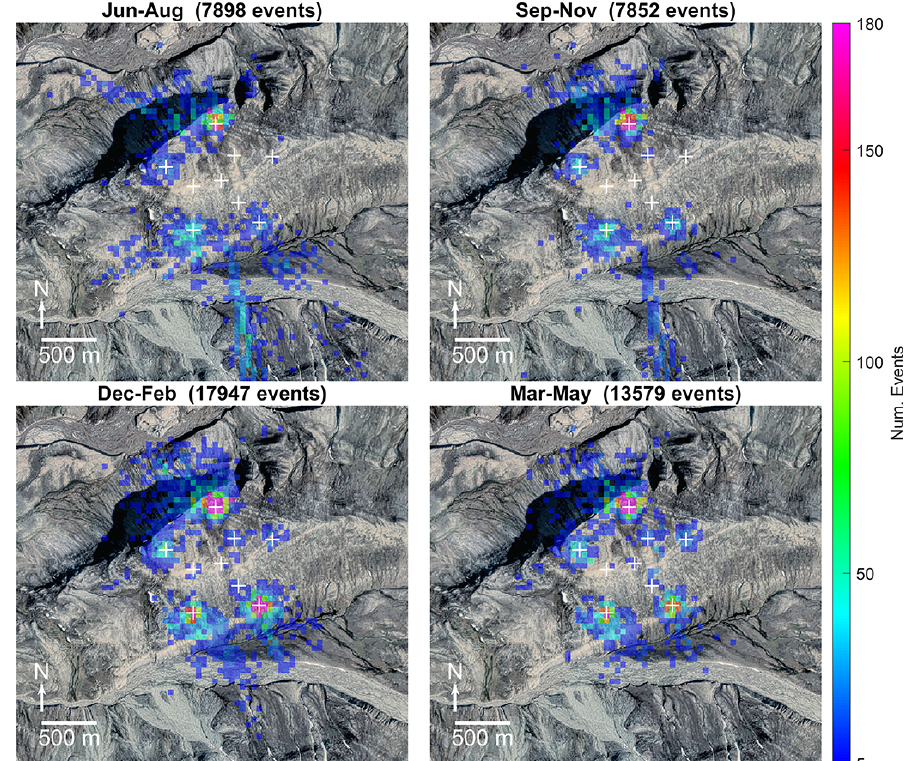
Figure 7. Detailed view of Janssonhaugen overlaid with spatially binned (50 × 50m) distribution of coherent-MFP-inferred seismic source positions plotted by season for events recorded between August 2004 and July 2021. Positions of SPITS seismometers are indicated by white crosses. Orthophoto © Norwegian Polar Institute (https://www.npolar.no/, 17 January 2022).